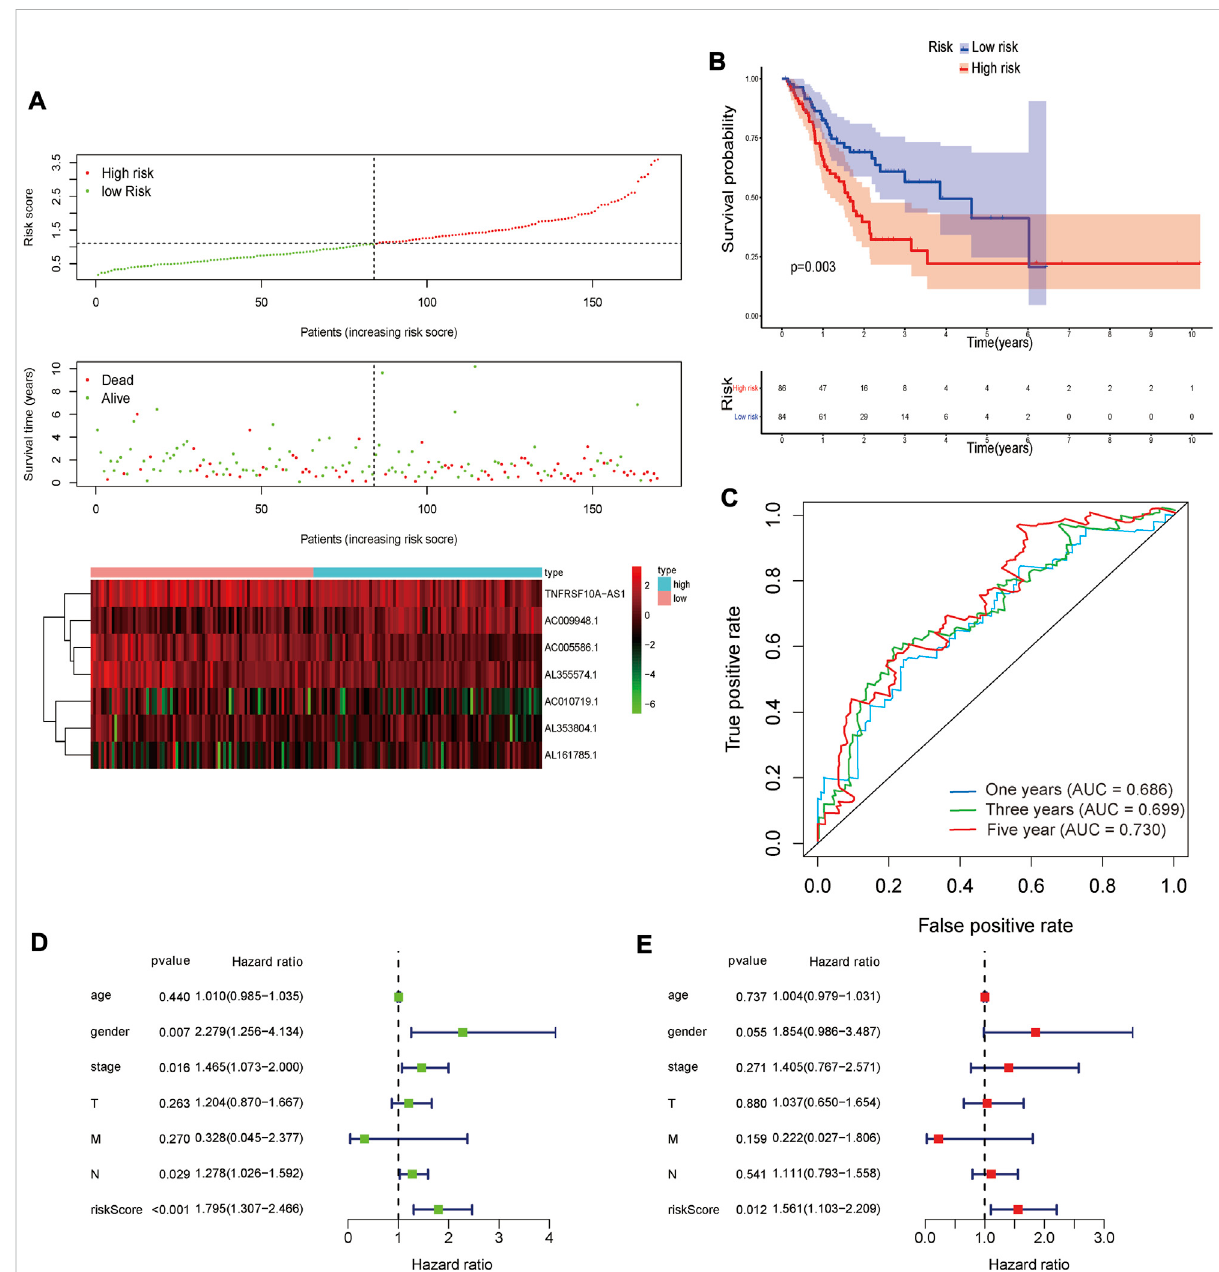
FIGURE 9 The result of validation cohort based on seven glycolysis-related lncRNAs in STAD. (A) The risk score, survival status and heat map of seven glycolysis-related lncRNAs between the high-risk and the low-risk group in validation cohort. (B) Kaplan-Meier survival curve of risk score in validation cohort. (C) The areas under the ROC curve about 1-, 3-, and 5-year in validation cohort. (D,E) The forest plots for univariate (D) and multivariate (E) Cox regression analysis in validation